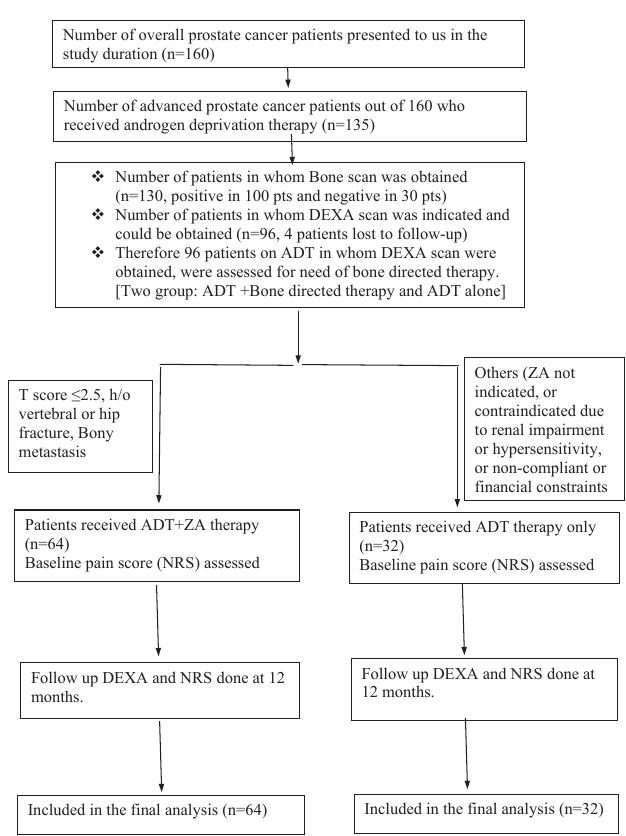
Figure 1 - Flow Chart of the